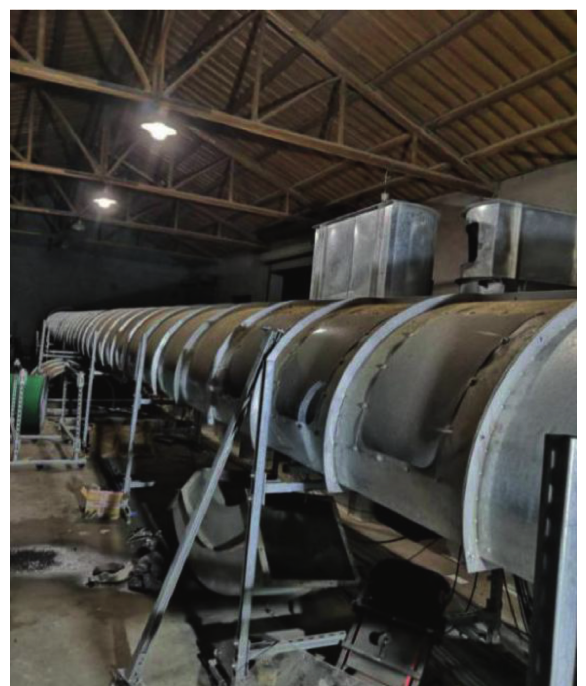
Figure 6: Site layout of the tunnel model.